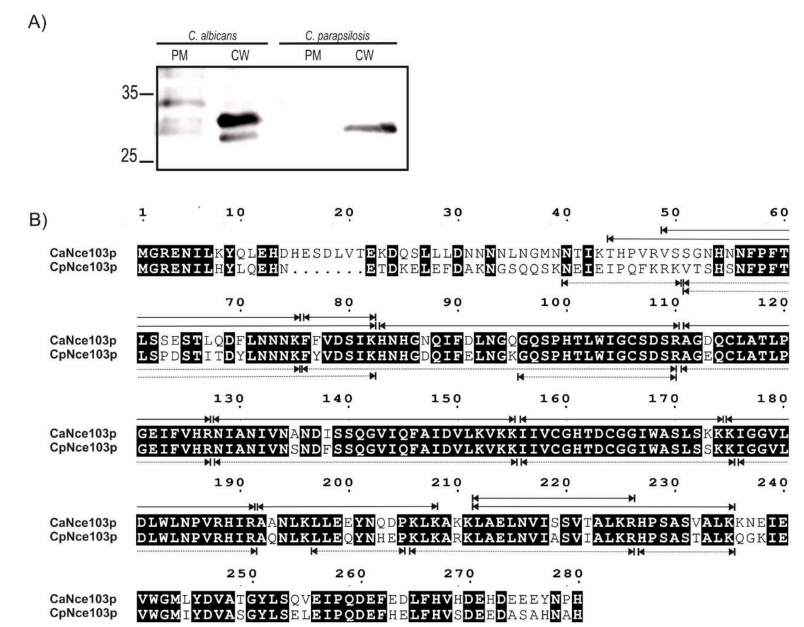
Figure 2. Analysis of Nce103p presence in PM and CW fractions of C. albicans and C. parapsilosis . ( A ) Western blot analysis of PM and CW fractions obtained using the protocol of Zinser and Daum [14]. CAs were detected using polyclonal rabbit antibodies against CpNce103p, diluted 1:1000. ( B ) Mass spectrometry (MS) analysis of CaNce103p and CpNce103p in C. albicans and C. parapsilosis CWs. The conserved amino acids are highlighted in black. Peptides detected by MS analysis are marked with arrows above (CaNce103p) or below (CpNce103p) sequences (CpNce103p, UniProtKB: G8B6R8 and CaNce130p,